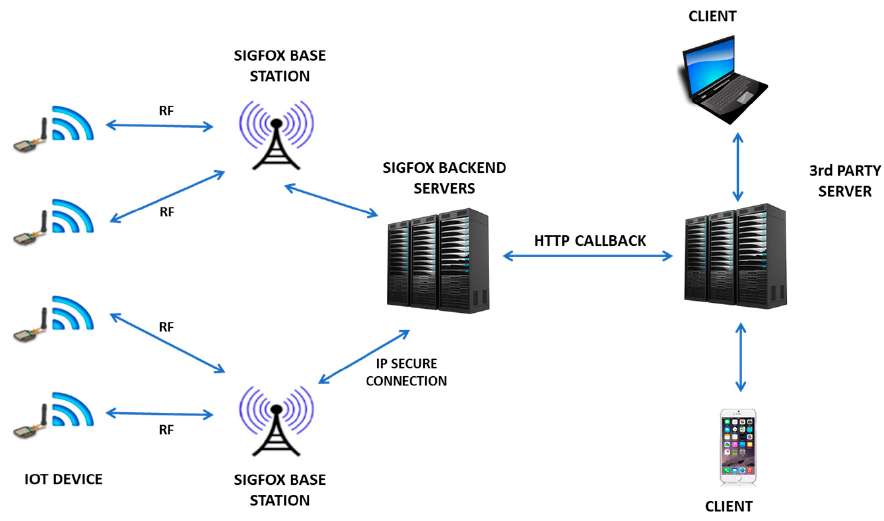
Figure 15. SIGFOX network topology.